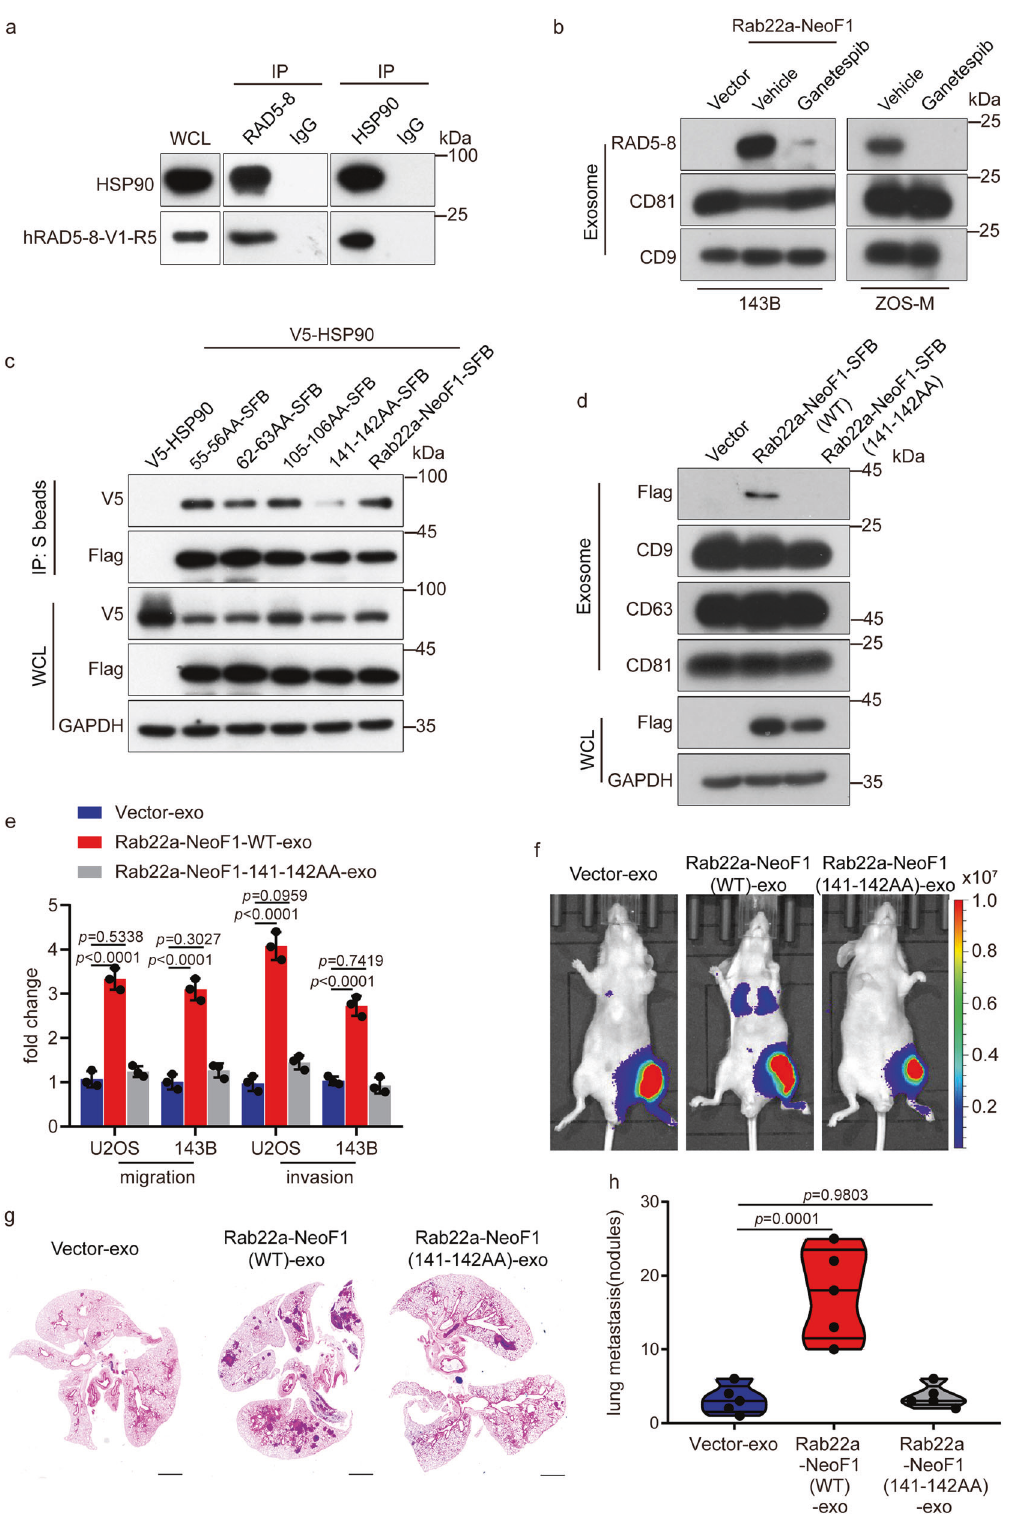
Rab22a-NeoF1 (Rab22a-NeoF1-exo) or Vector (Vector-exo) were performed, and 173 among over 2000 proteins were differently expressed in these two groups of exosomes (Supplementary Fig. 4a, b). Notably, PYK2, sharing similar domain organization with focal adhesion kinase (FAK), that has been reported to